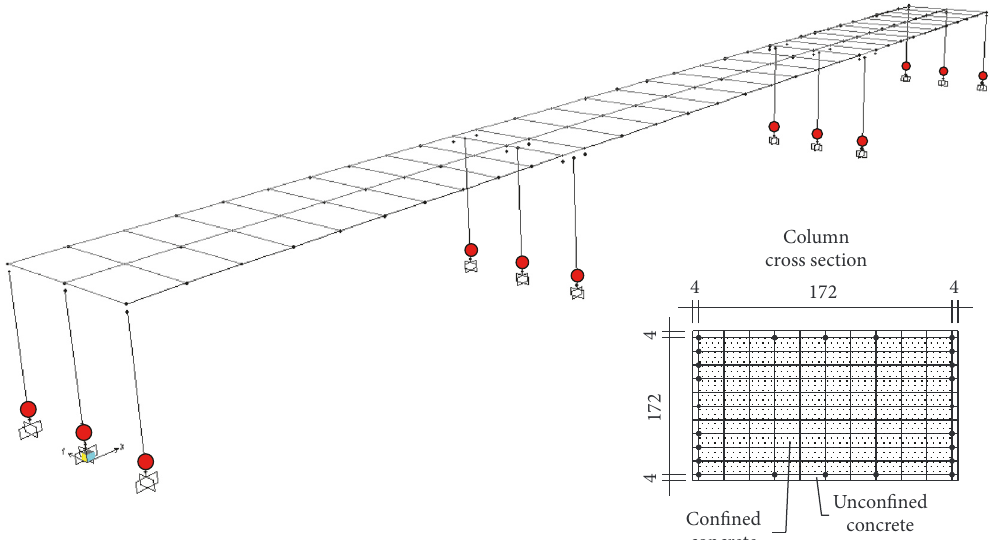
Figure 6: 3D view of existing bridge FEM model and column base cross-section